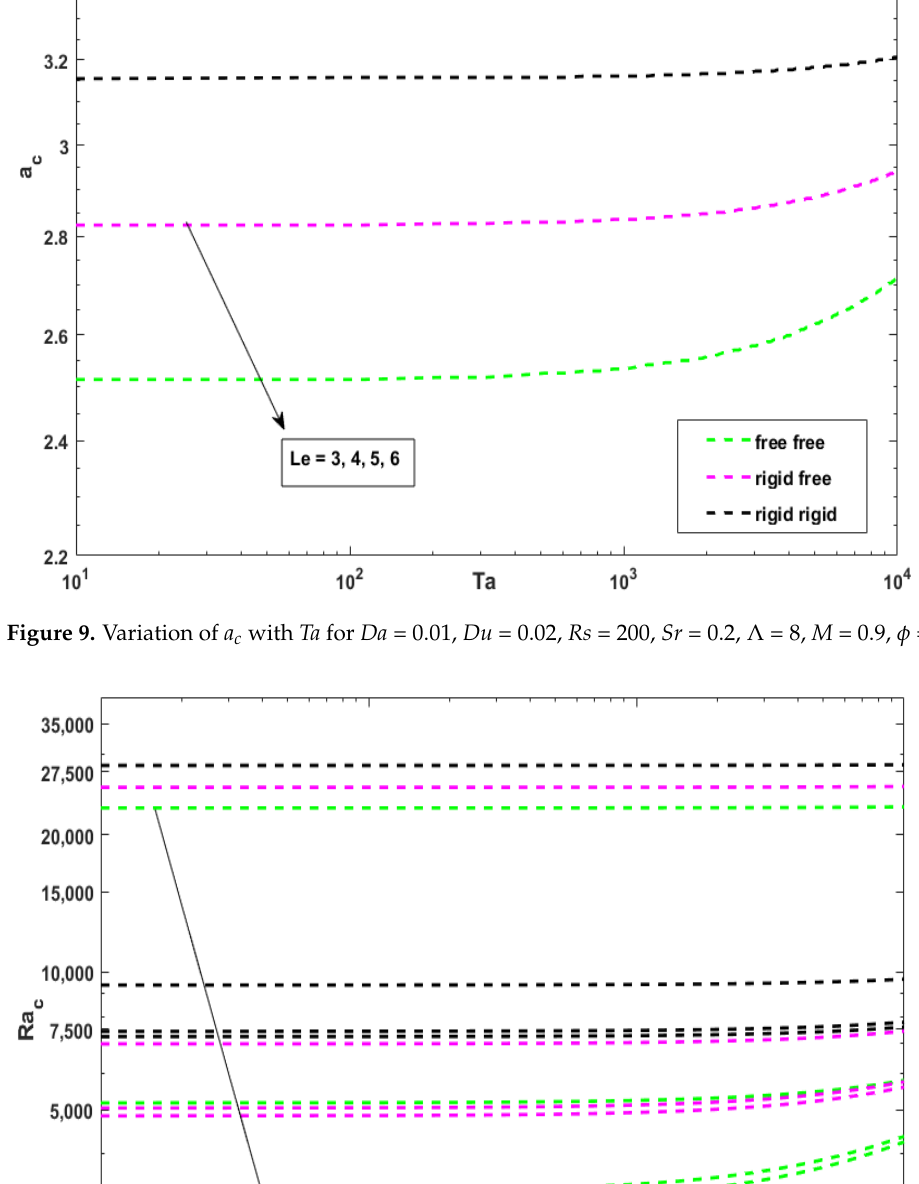
Figure 8. Variation of Ra c with Ta for Da = 0.01, Du = 0.02, Rs = 200, Sr = 0.2, Λ = 8, M = 0.9, ϕ = 0.9.